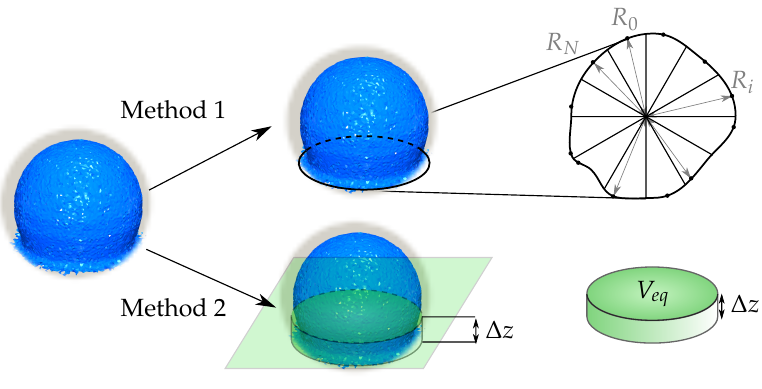
Figure 5. Illustration of the methods to determine the liquid contact surface.